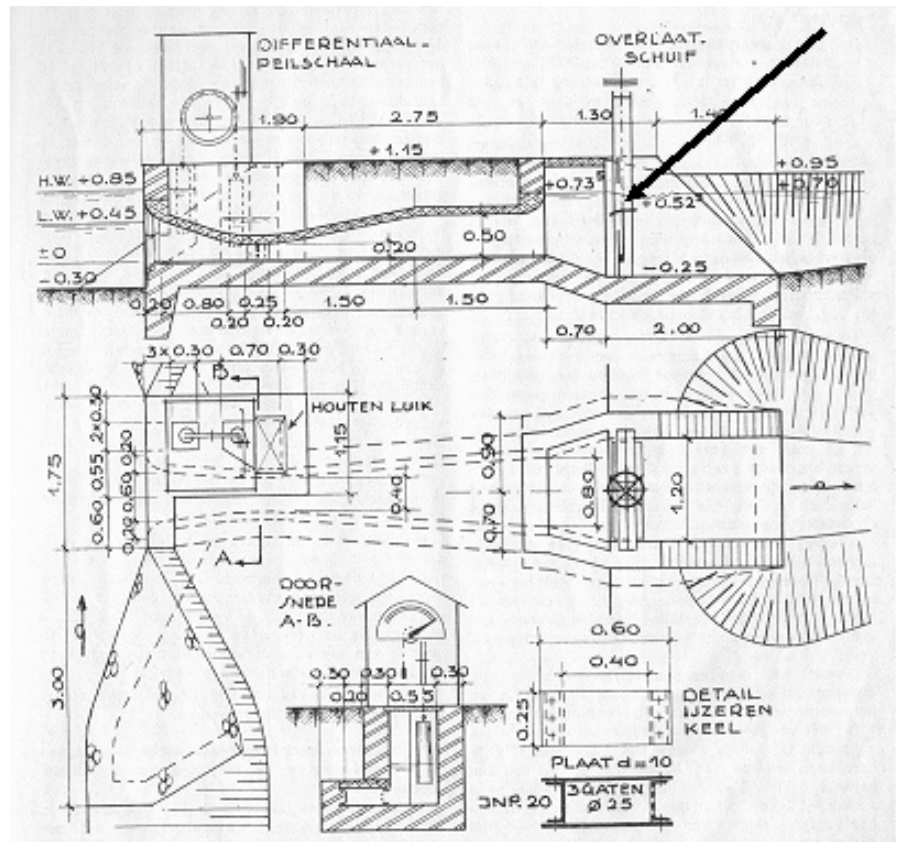
Figure 4 The overflow weir attached to the Venturi